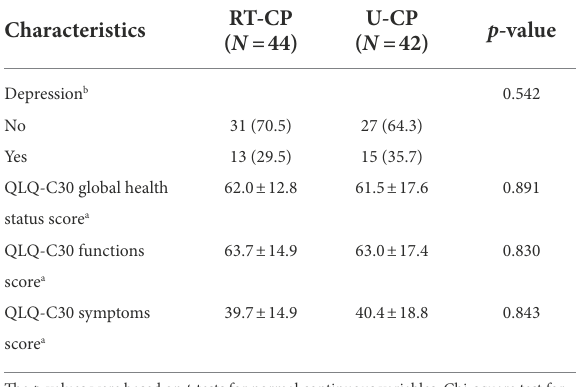
TABLE 1 Comparison of baseline characteristics among the older PTC